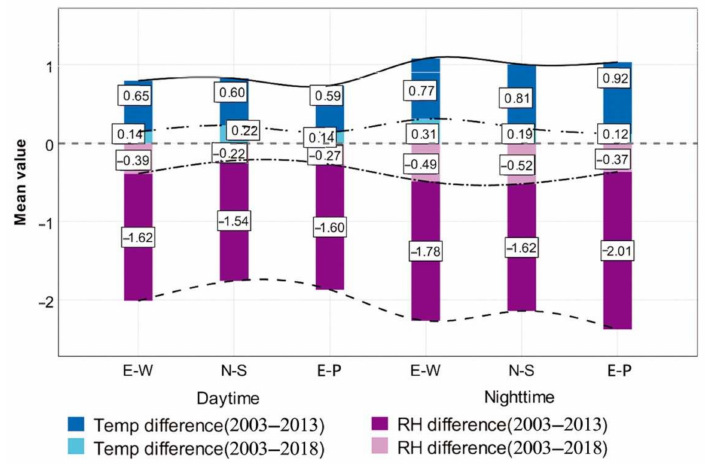
Figure 7. The mean difference values profile of air temperature (AT) and relative humidity (RH) from 2003 to 2018.